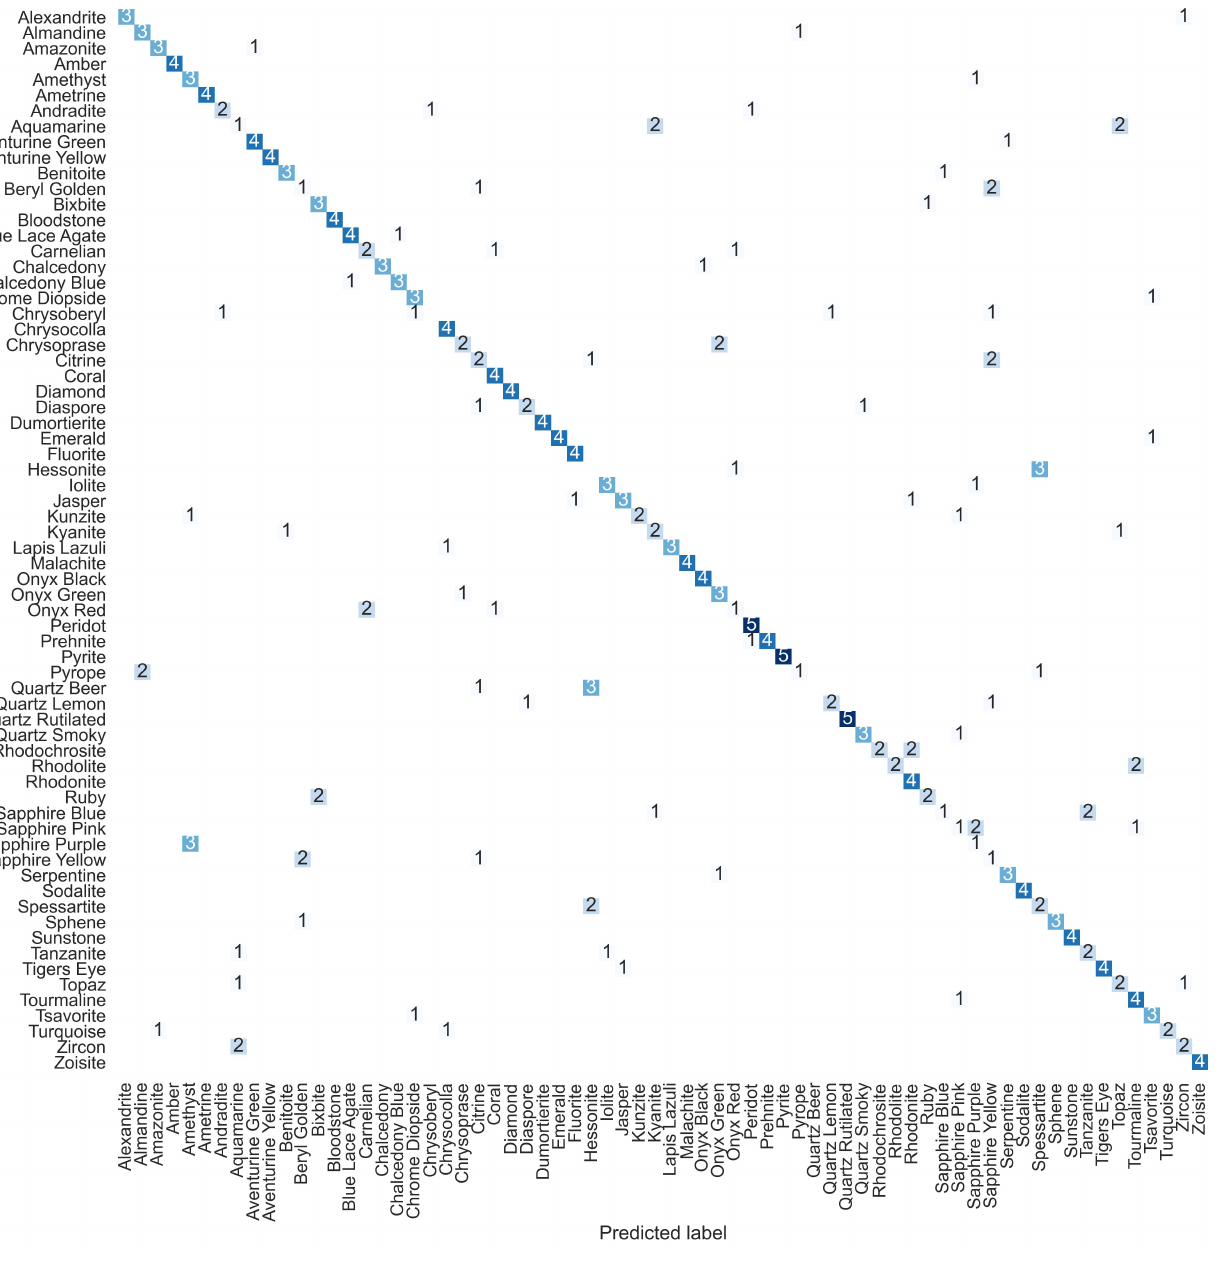
Figure 10. Confusion matrix of the best gemmologist revealing the poorest ability in distinguishing between similarly coloured gemstones, namely Sapphire Purple and Amethyst; Hessonite and Spessartite; Quartz Beer and